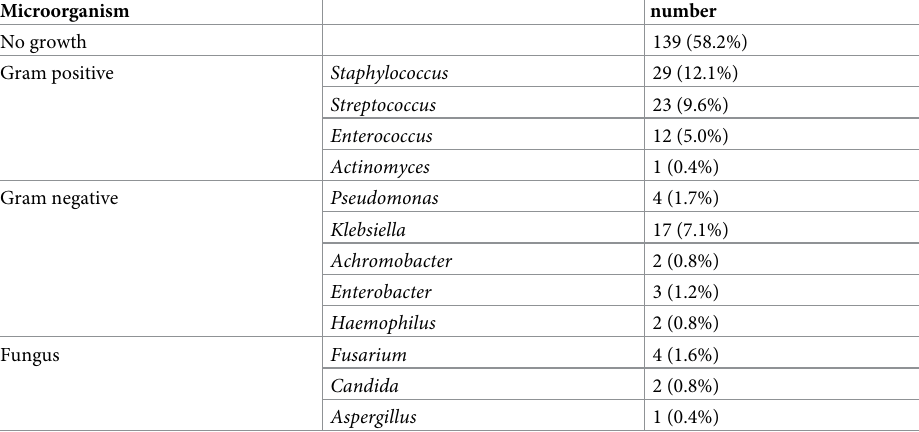
Table 2. Microorganisms of patients with infectious